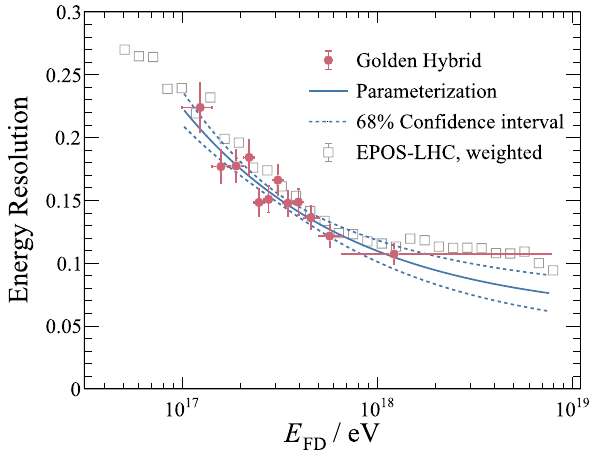
Fig. 9 The total SD energy resolution, as calculated using the golden hybrid events (red circles) is shown in bins with equal statistics. The parameterizationoftheresolutionisshownbythesolidbluelineandthe corresponding 68% confidence interval in dashed lines. The energy res- olution,calculatedusingmass-weightedMCairshowers(graysquares), is shown as a verification of the